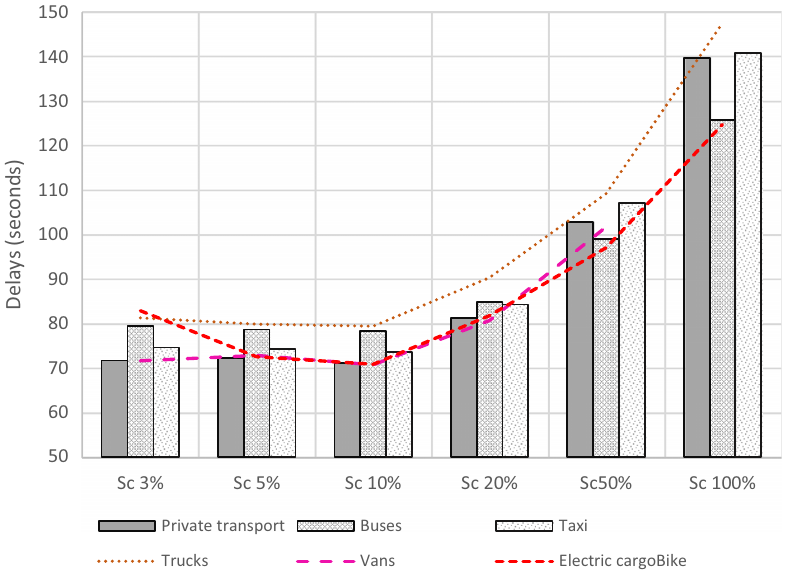
Fig. 4 Delay times according with vehicles typology for different electric cargo bikes market penetration rates